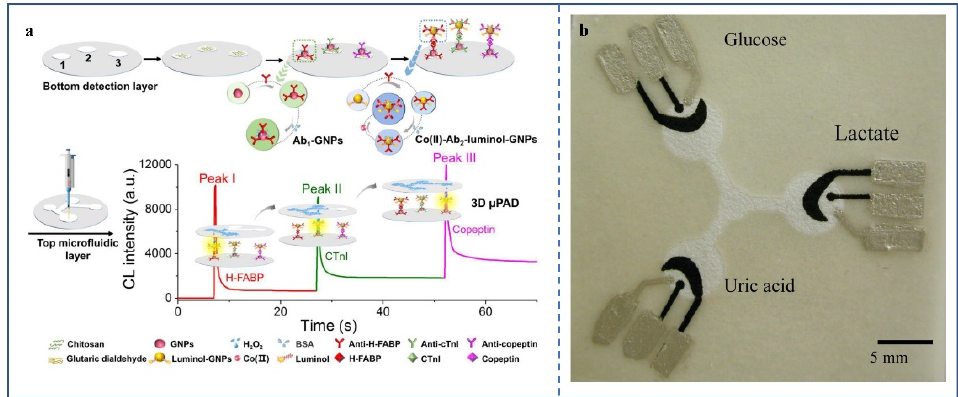
Figure 5. ( a ) Structure and the principle of 3D μ PAD for H-FABP, cTnI, and copeptin multiplexed CL immunoassays [48] (Copyright © 2022 Elsevier B.V. All rights reserved.). ( b ) Picture of first μ PAD based on electrochemical signals [15]. The center of the white area is hydrophilic and draws the sample into three reaction zones containing electrodes. The silver electrode and contact pad are made of Ag/AgCl paste, and the black electrode part is a lead-modified carbon electrode. (Copyright © 2022, American Chemical Society).